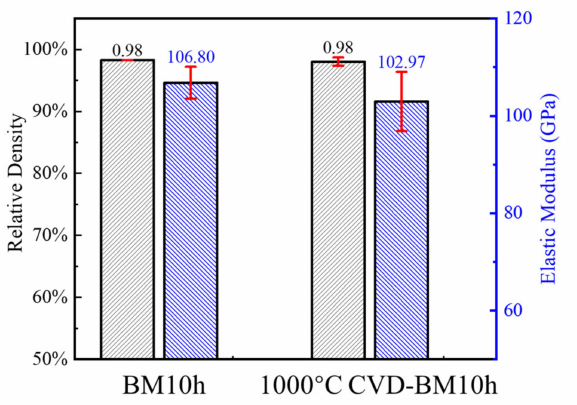
Figure 12. Density and elastic modulus of composites made by BM10h and 1000 ◦ C CVD-BM10h.